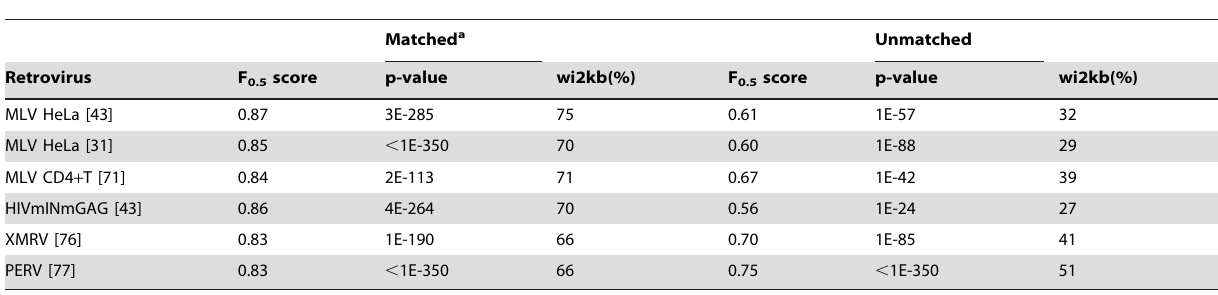
Table 5. Association of supermarker with